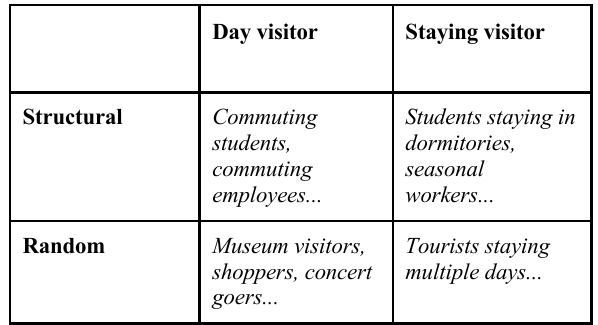
Table 1. Visitors are categorised based on how long they